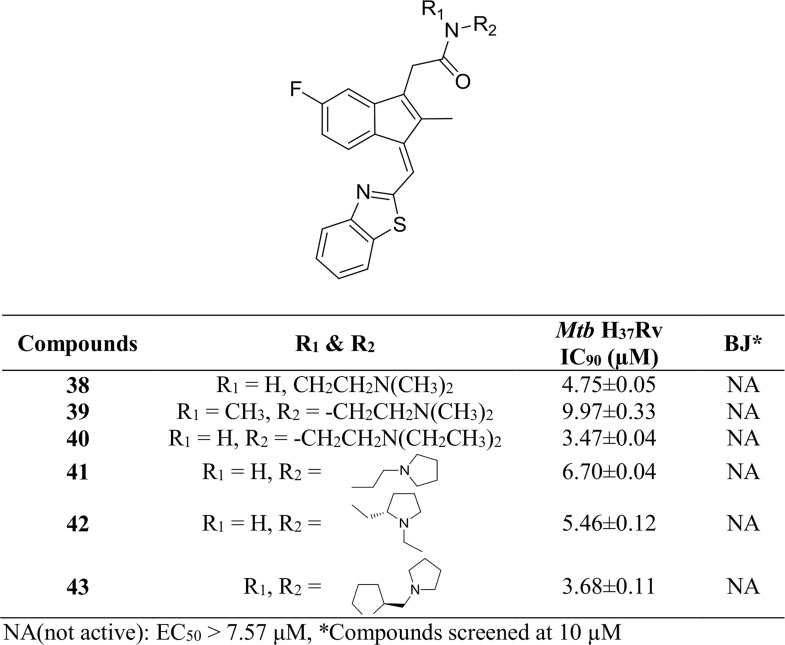
Mtb H37Rv and BJ cell data of benzothiazolyl Sulindac amide derivatives 38–43.